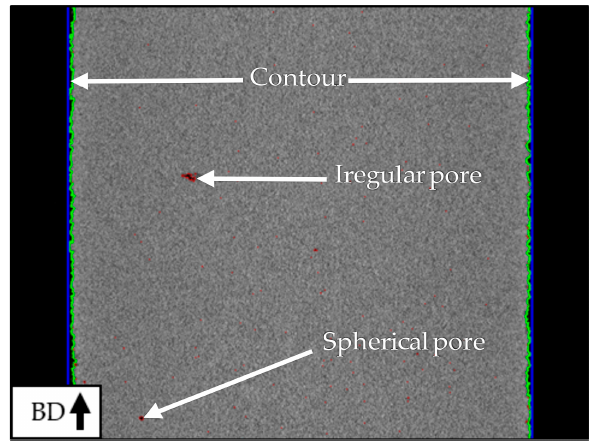
Figure 6. Computer tomography image of cylindrical titanium specimen.